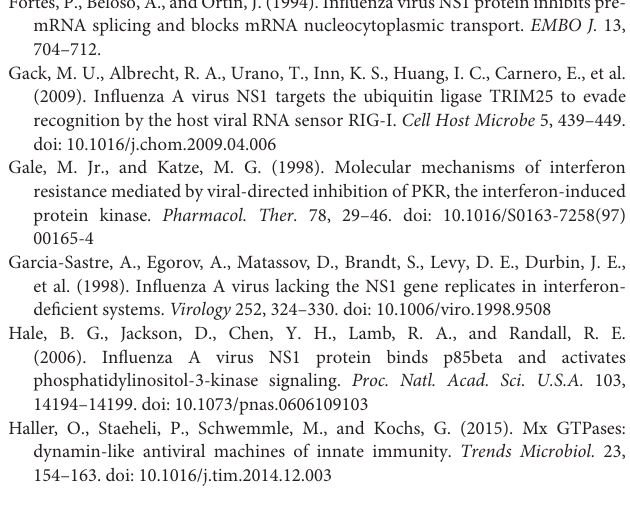
FIGURE S1 | In vitro co-precipitation of NS1 with UAP56 mutants. HEK293T cells were transfected with a protein expression vector for wild-type (WT) WSN-NS1 protein and FLAG-tagged WT or mutant UAP56 protein or a control vector. K95A and K95N: UAP56 mutants which lack ATPase activity due to